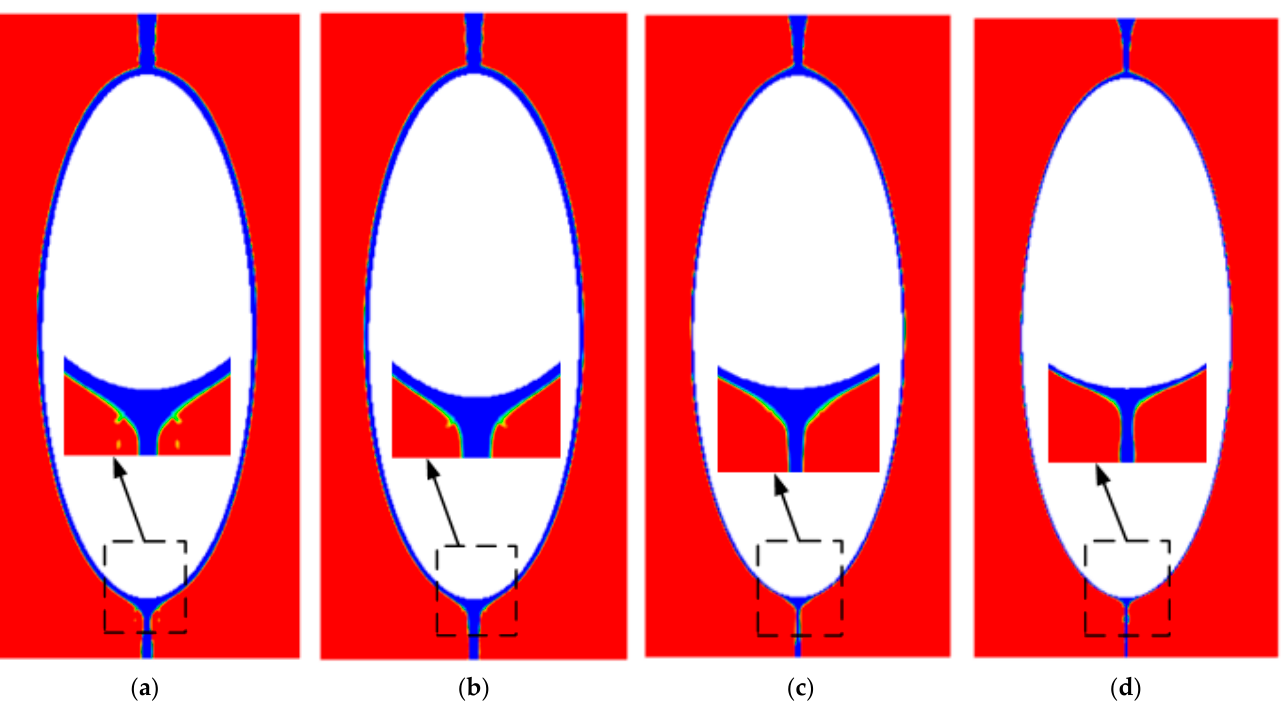
Figure 18. Film distribution on the elliptical tube: ( a ) water; ( b ) seawater; ( c ) R290; and ( d ) O 2 .